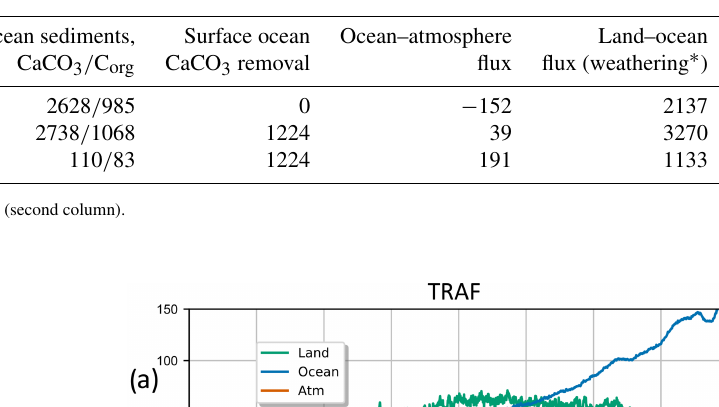
Table 1. Changes in compartments and cumulative fluxes at 1850CE relative to 6000BCE (PgC).